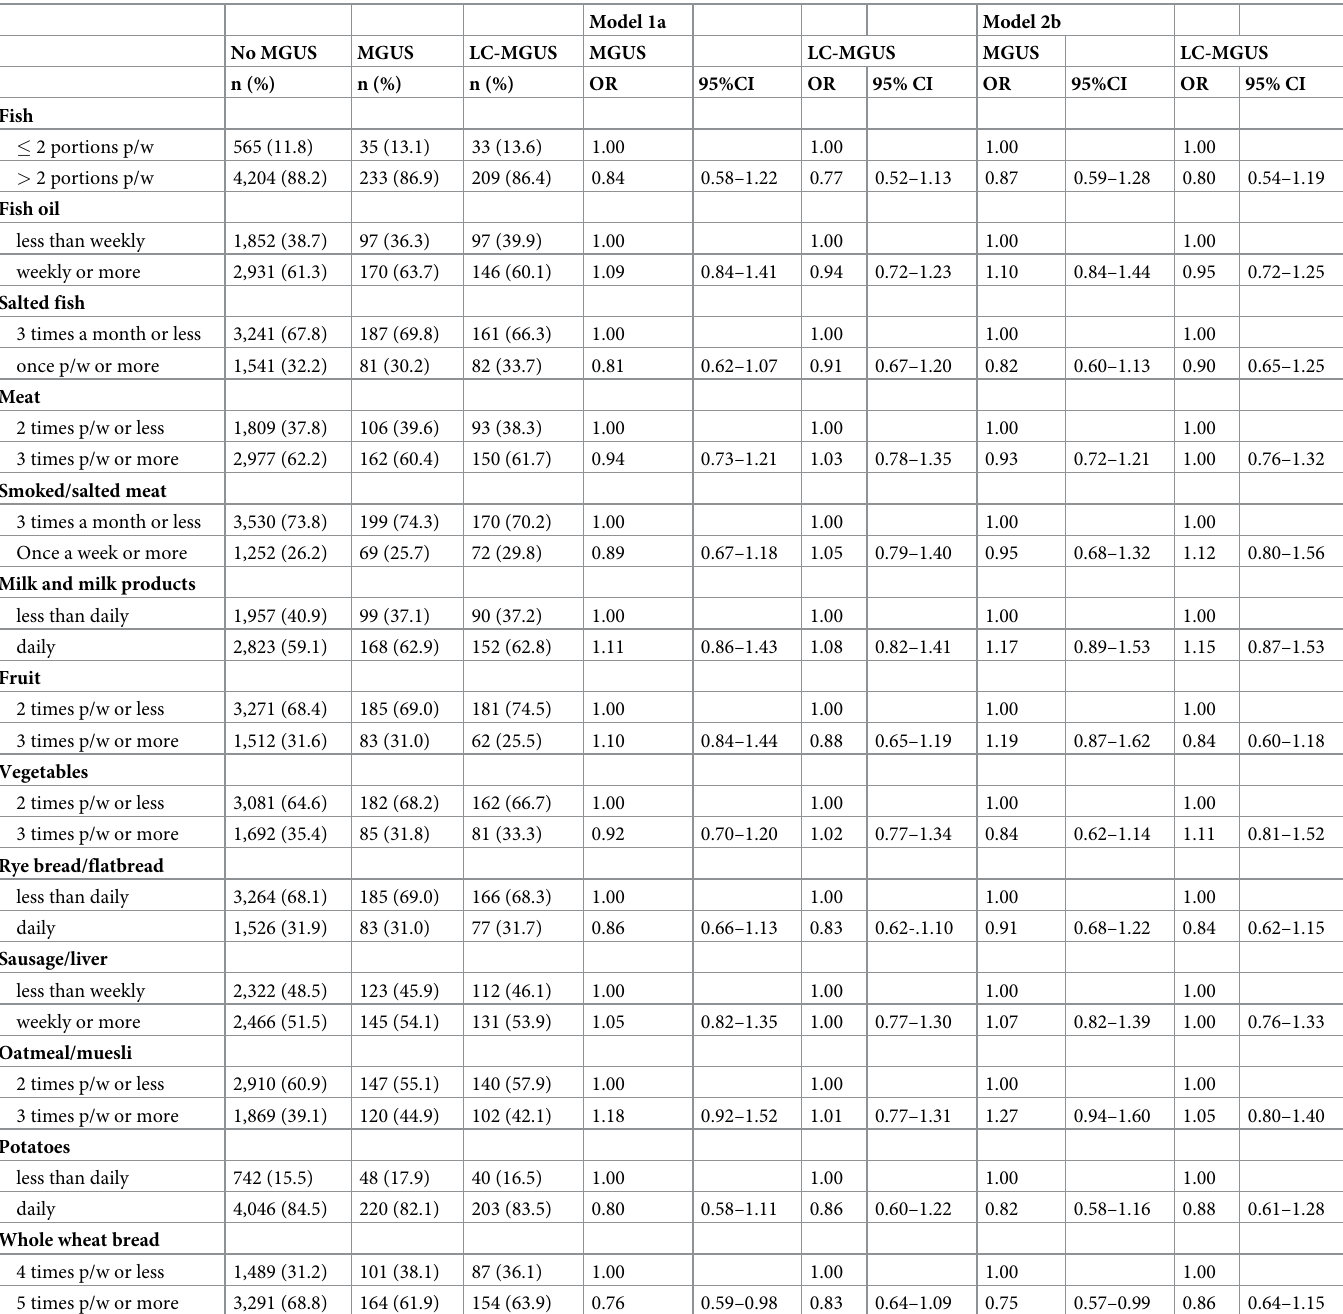
Table 3. The association between midlife diet and MGUS and